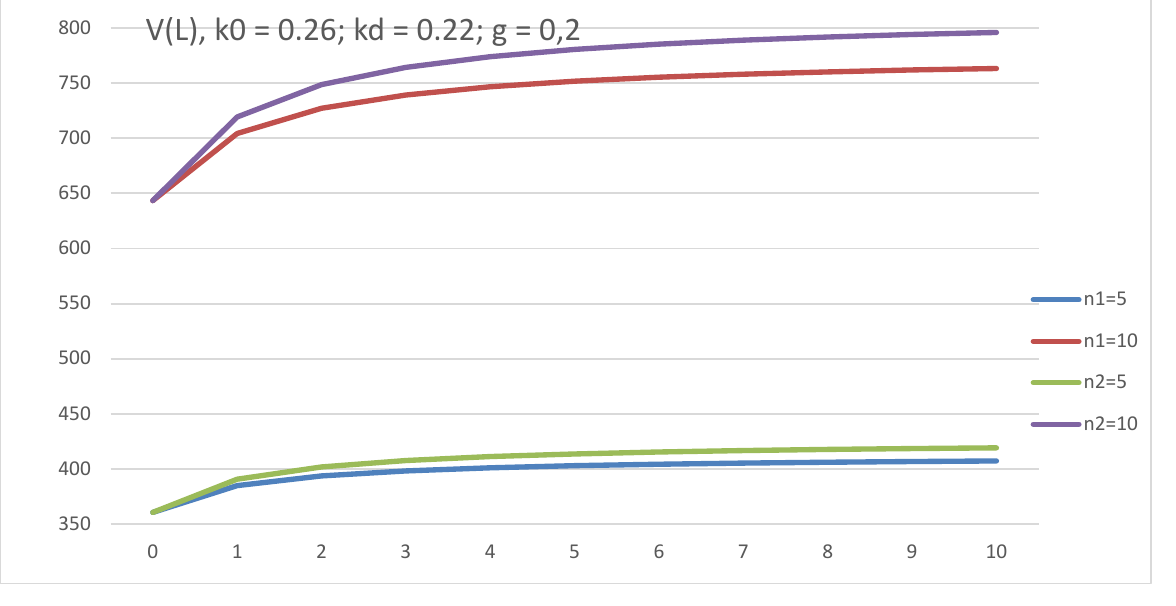
Figure 14. The dependence of company value, V, on leverage level, L, in GBFO theory with payments of tax on profit at the end of periods (1) and advance payments (2) at k 0 = 0.26; k d = 0.22; t = 0.2; g = 0.2, for five-year and ten-year companies.